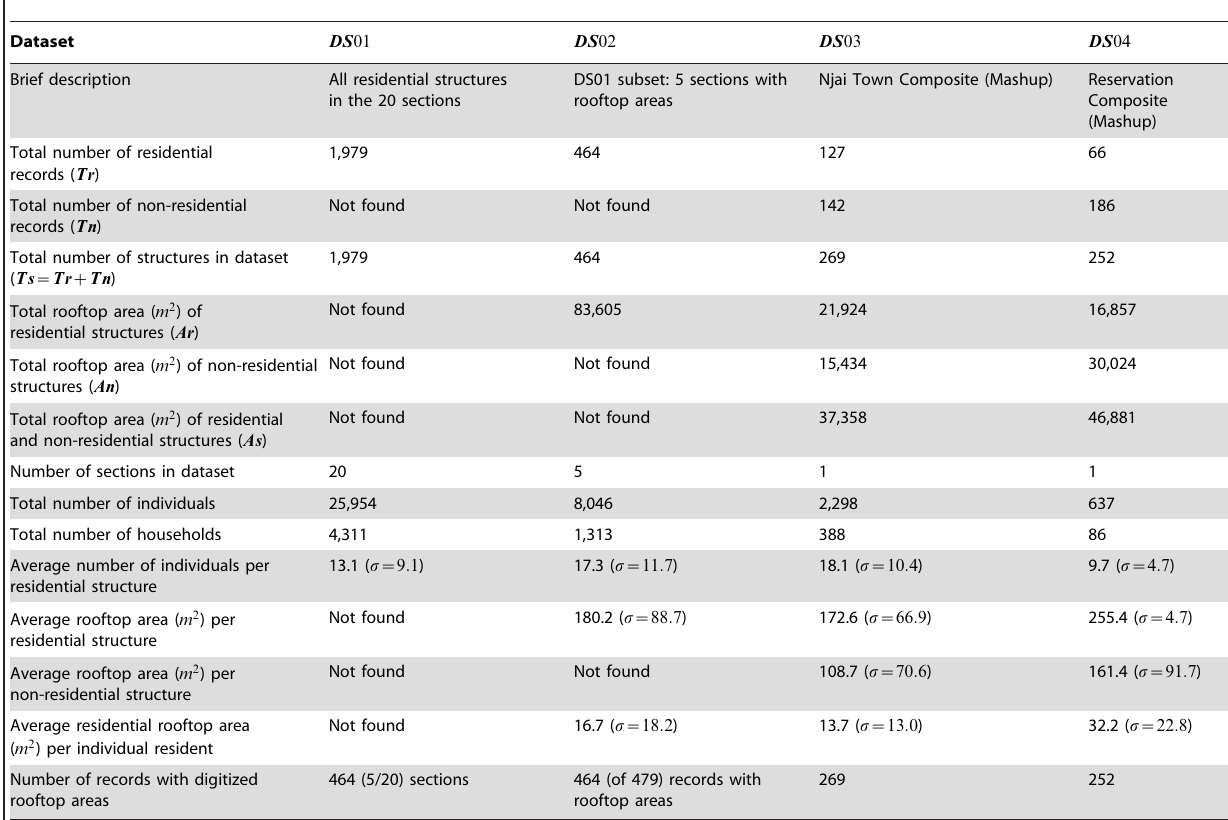
Table 3. Summary of the four datasets used for the simulation.